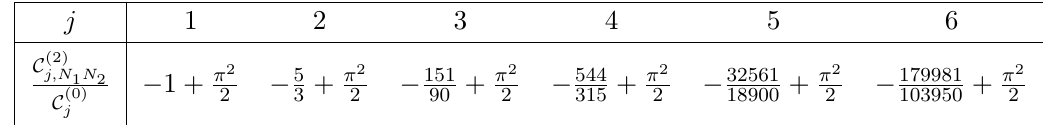
Table 3. The two-loop normalized structure constants of